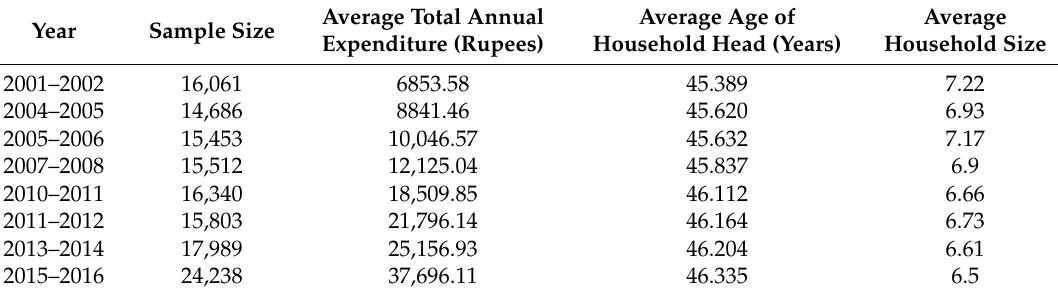
Table 1. Summary